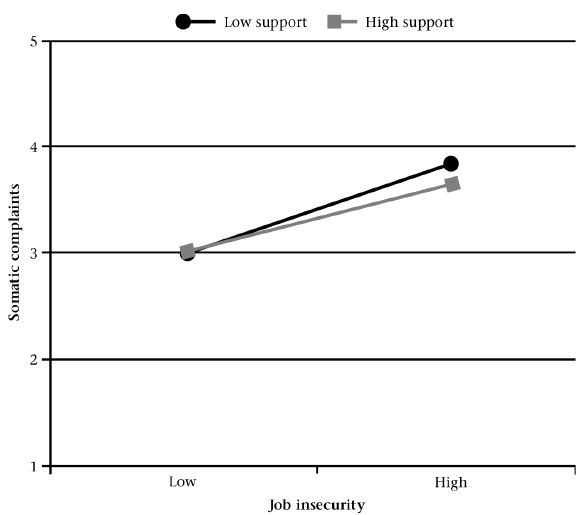
Figure 2: Interaction between job insecurity and non-work based support on somatic complaints